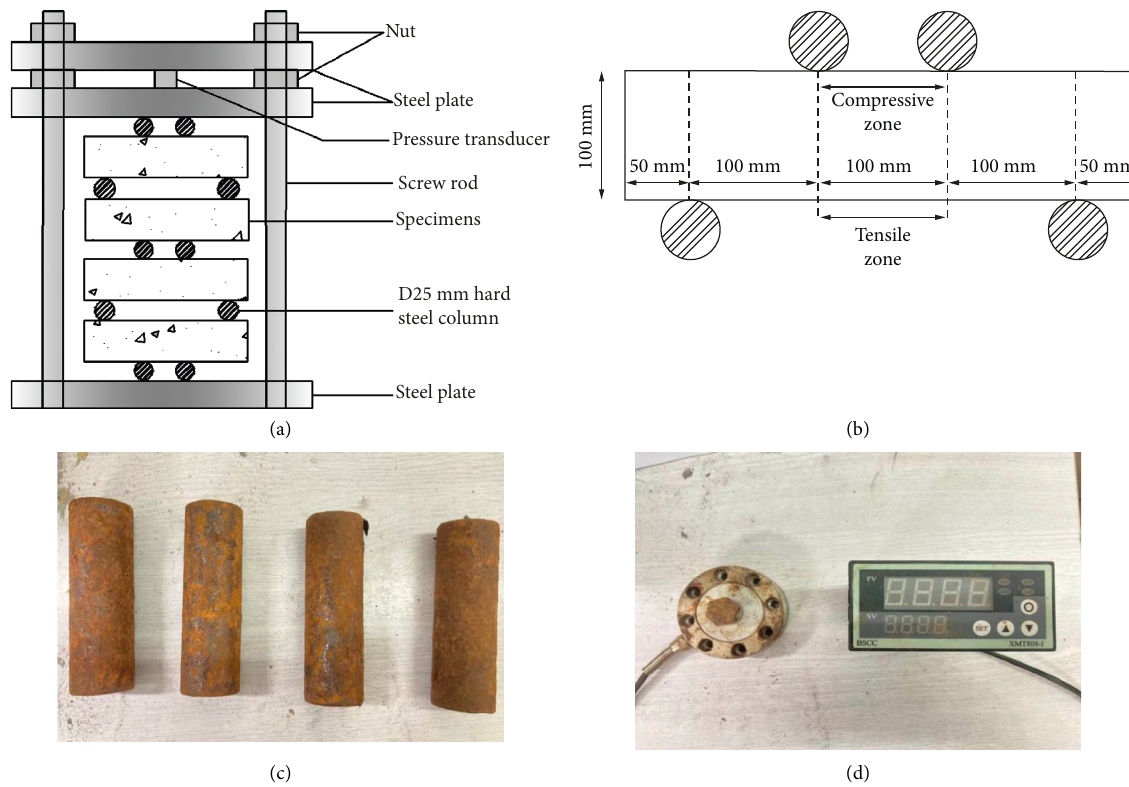
Figure 2: (a) Schematic diagram of the loading equipment. (b) 25mm hard steel column arrangement and drilling positions in tensile and compressive zone diagram. (c) 25mm hard steel column. (d) Pressure